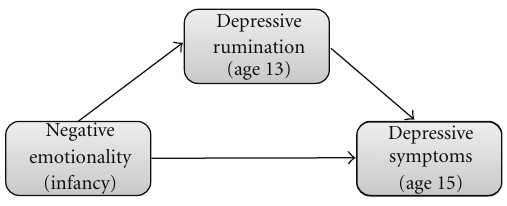
Figure 1: Conceptual